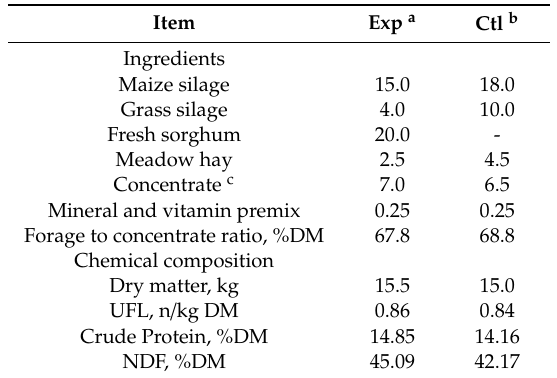
Table 1. Ingredients (kg as feed / day per head) and chemical composition of the total mixed ration fed to bu ff alo